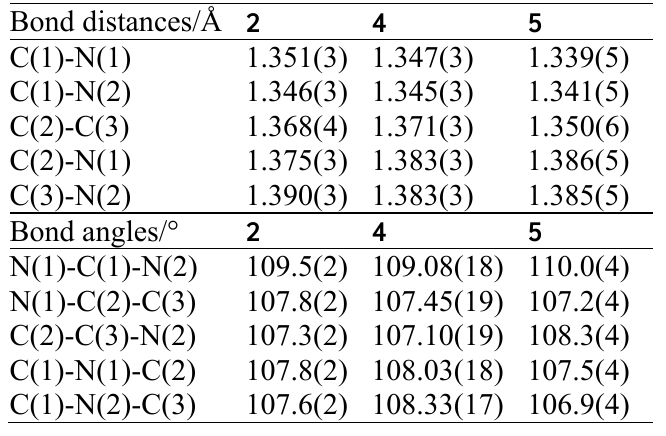
Table 2. Selected bond distances (Å) and angles (°) for compounds 2 , 4 and 5 .